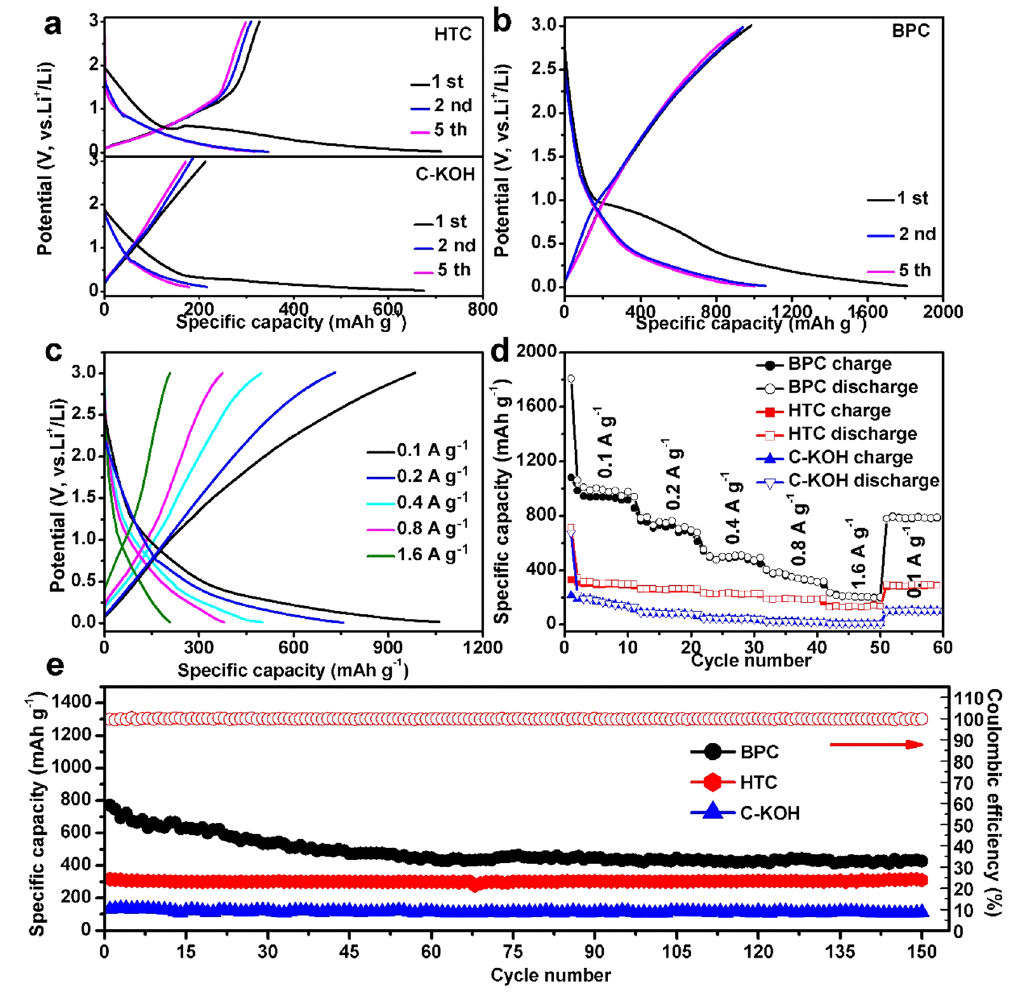
Figure 4. Galvanostatic charge and discharge profiles of HTC, C-KOH ( a ) and BPC ( b ) at 100 mA g − 1 from 0.01 V to 3.00 V for the 1st, 2nd and 5th cycle. ( c ) Charge-discharge curves of BPC at various current densities. ( d ) Cycling performances of BPC at different current densities from 0.1 A g − 1 to 1.6 A g − 1 . ( e ) Cycling capability of three samples at a current density of 0.2 A g − 1